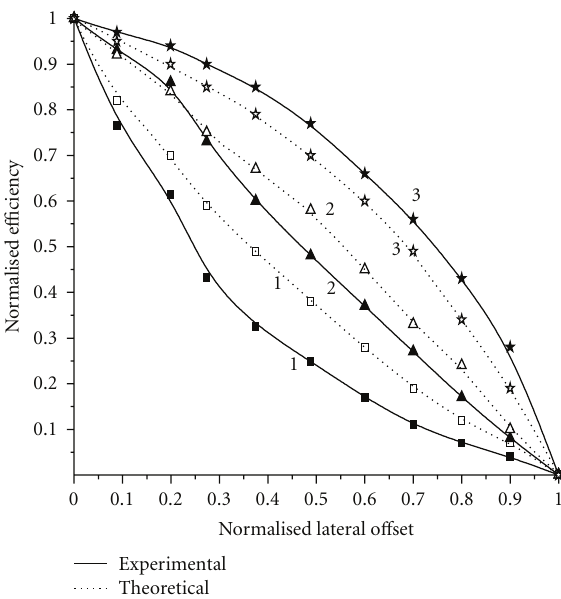
Figure 6: The power coupling e ffi ciency η is shown as a function of fibre relative core-cladding refractive index di ff erence Δ in percent for di ff erent index mismatch Δ c